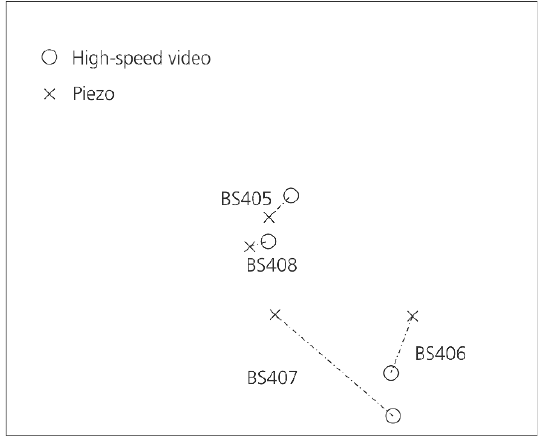
Fig. 10 Location of initial crack: Comparison of the optical determined location and location determined with acoustic emission testing (tests BS405 to